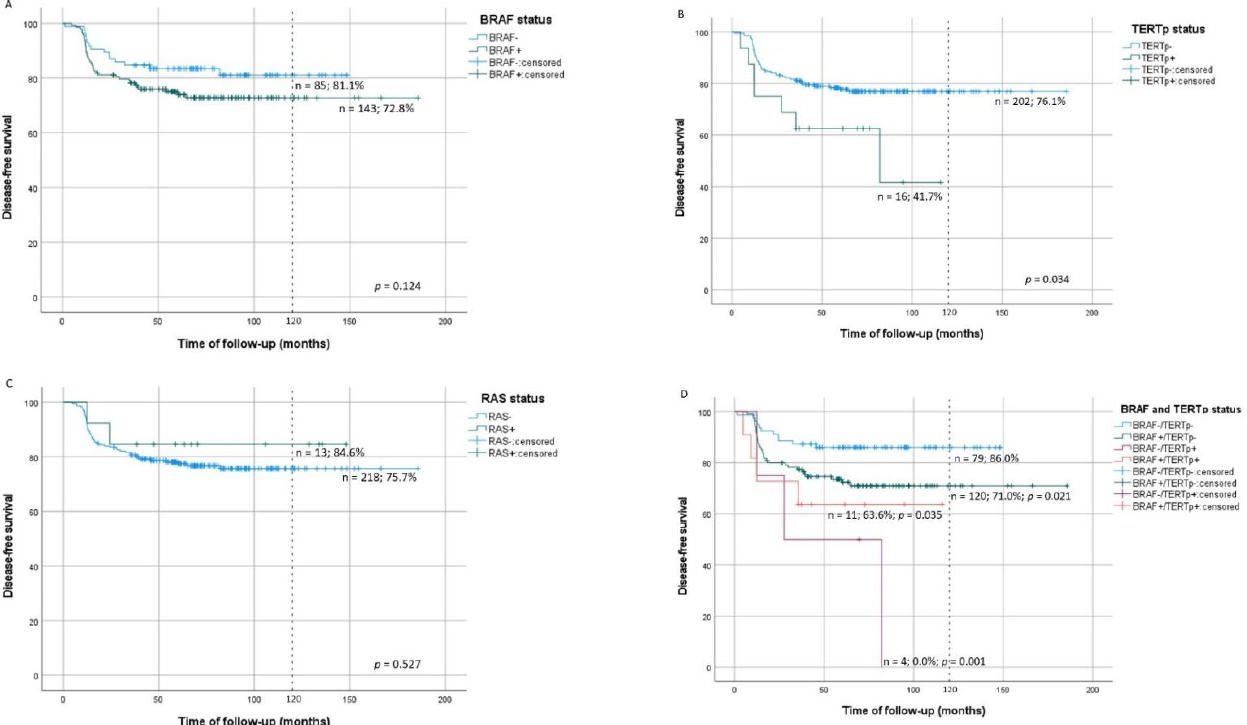
Figure 1. Kaplan–Meier curves of PTC of recurrent/persistent disease-free survival by tumor molecular status in comparison with wild type tumors; ( A ) BRAF status, ( B ) TERTp status, ( C ) RAS status, ( D ) combined BRAF and TERTp status in comparison to wild-type tumors; wt: wild-type; mut: mutated. Table 3. Analysis of molecular status in the risk of recurrent/persistent disease.